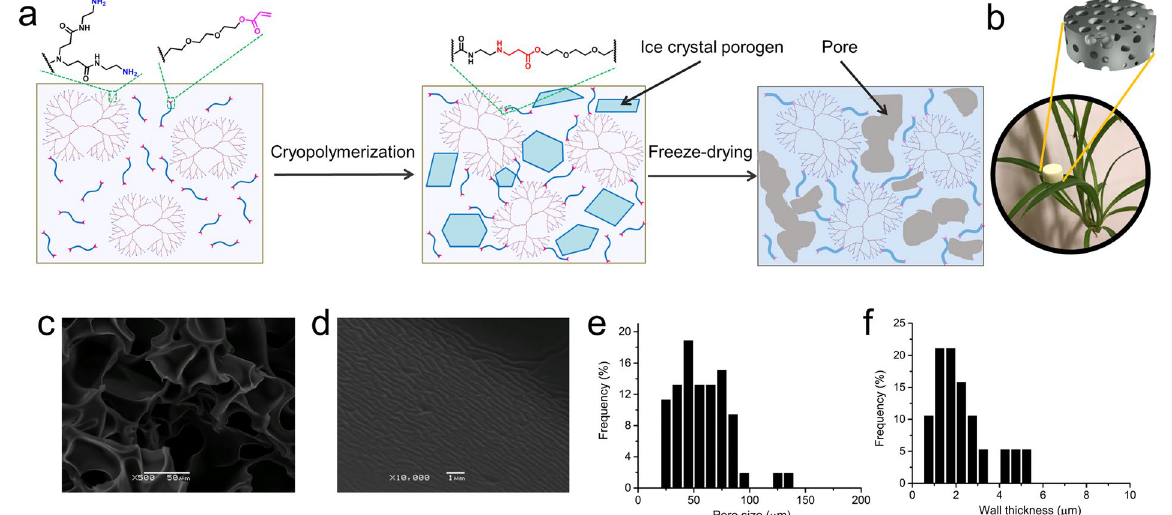
Figure 1. Fabrication, morphological illustration, and characterization of dendrimer cryogel CG-G4-5%. ( a ) Schematic illustration of the preparation of the dendrimer cryogel by aza-Michael addition-based cryopolymerization and freeze-drying. ( b ) A leaf supports the elastic dendrimer cryogel, suggesting its ultralight weight (density: 0.27 g/cm 3 ). ( c ) SEM image reveals its porous structure. ( d ) SEM image inset shows the anisotropic surface texture of the pore wall. ( e ) Pore size distribution in the dendrimer cryogel. ( f ) Pore wall thickness distribution in the dendrimer